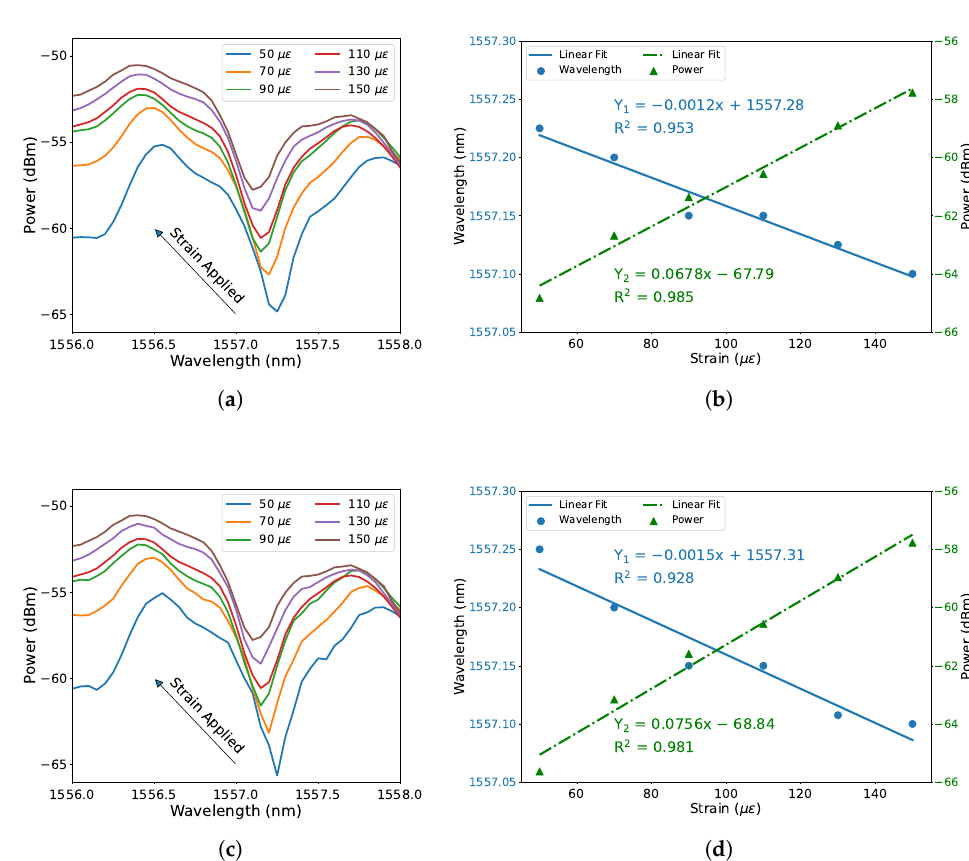
Figure 4. Measured dependence of spectral dip shifts on strain in the range of 50 μ 𝜀 to 150 μ 𝜀 in steps of 20 μ 𝜀 , ( a ) first round and ( c ) second round. Dip shift as a function of strain, ( b ) first round and ( d ) second round. The blue solid line represents dip wavelength shift against strain, and the green dash-dot line represents dip power against strain.